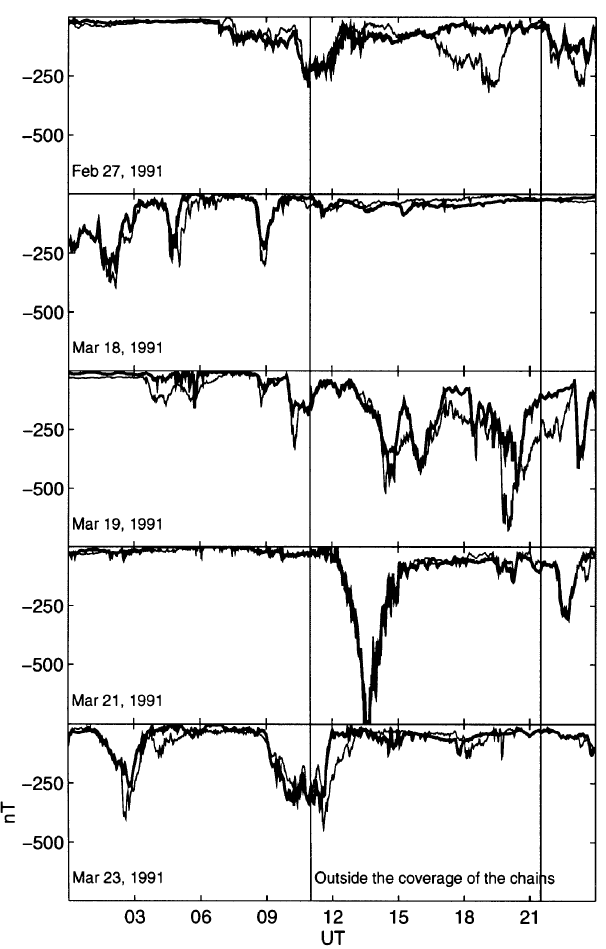
Fig. 8. A ‚ (cid:49)(cid:55) ( heavy solid line ) and the real A ‚ index ( thin solid line ) during 5 days from February — March 1991